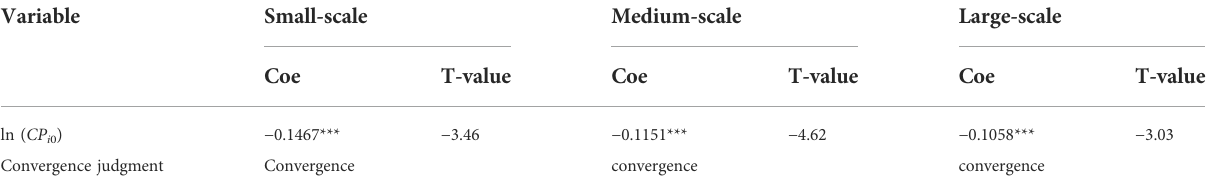
TABLE 3 Absolute β convergence of environmental ef fi ciency of dairy farming on different scales